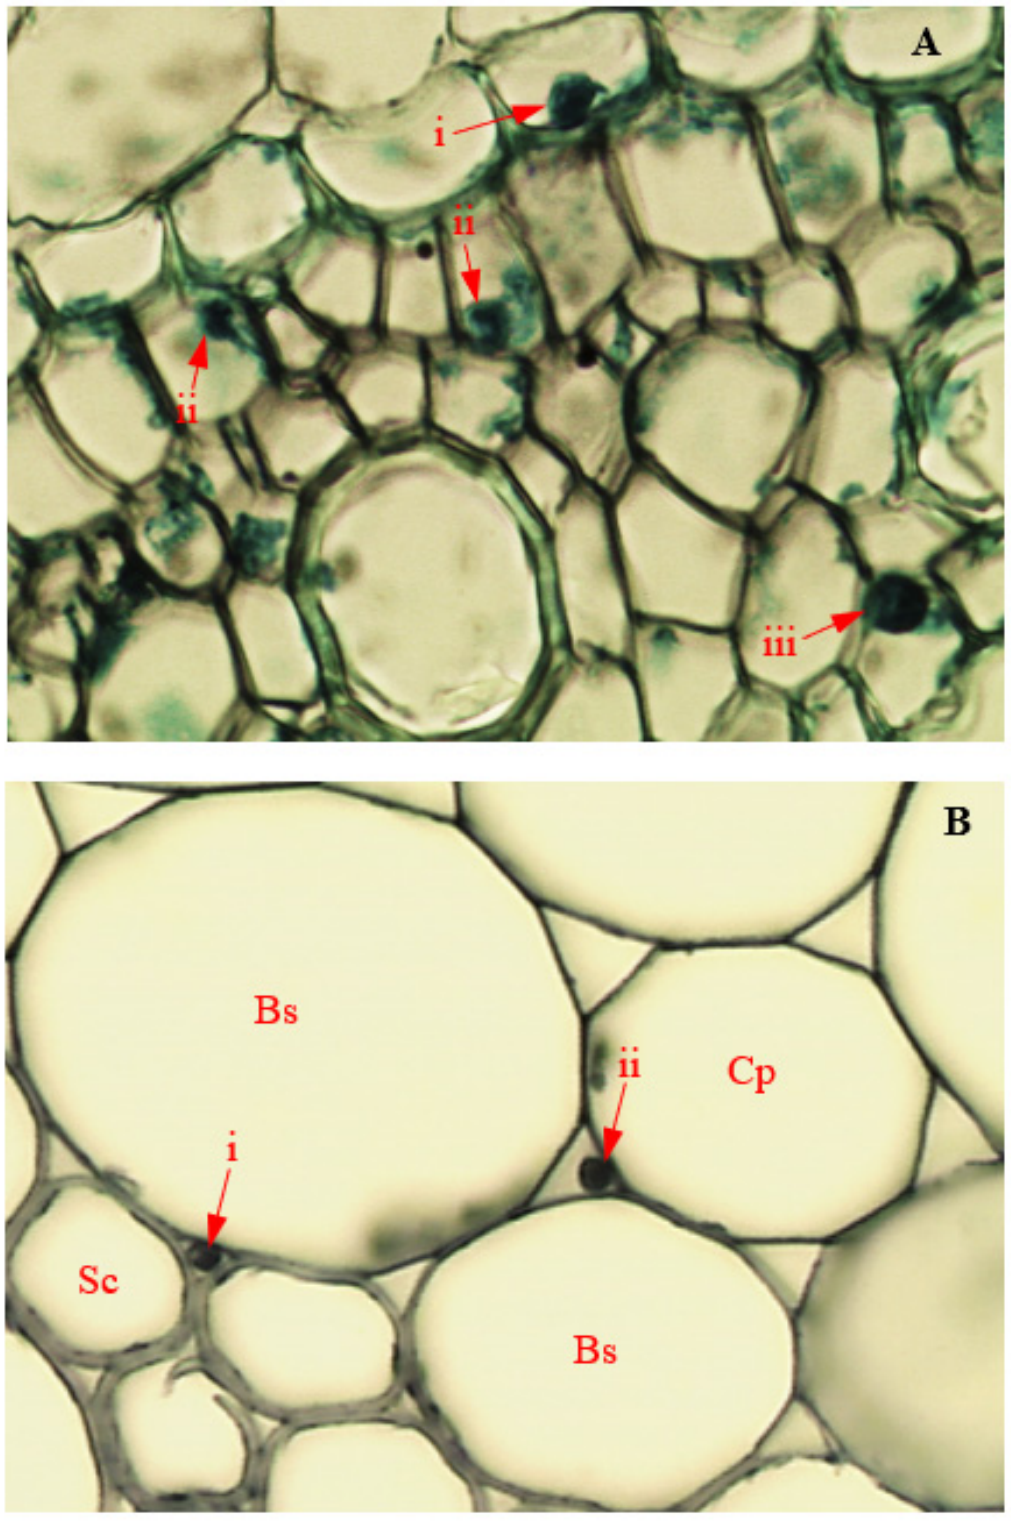
Figure 14. Light micrographs showing endophytic colonization of corn tissues by Fusarium sacchari (Magnification 400 × ). Red arrows indicate position of endophyte in infected ( A ) i: root endodermis; ii: root pericycle; and iii: root pith; ( B ) intercellular spaces between ( B ) i: stem sclerenchyma (Sc) and bundle sheath cells (Bs); and ii: stem bundle sheath cells (Bs) and cortical parenchyma